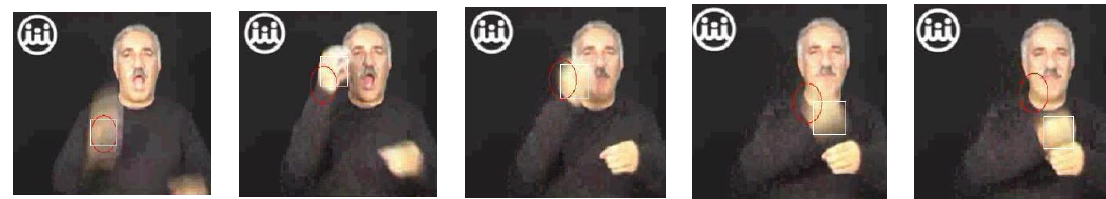
Figure 8. Hand tracking for complicated image by applying mean shift and motion detection